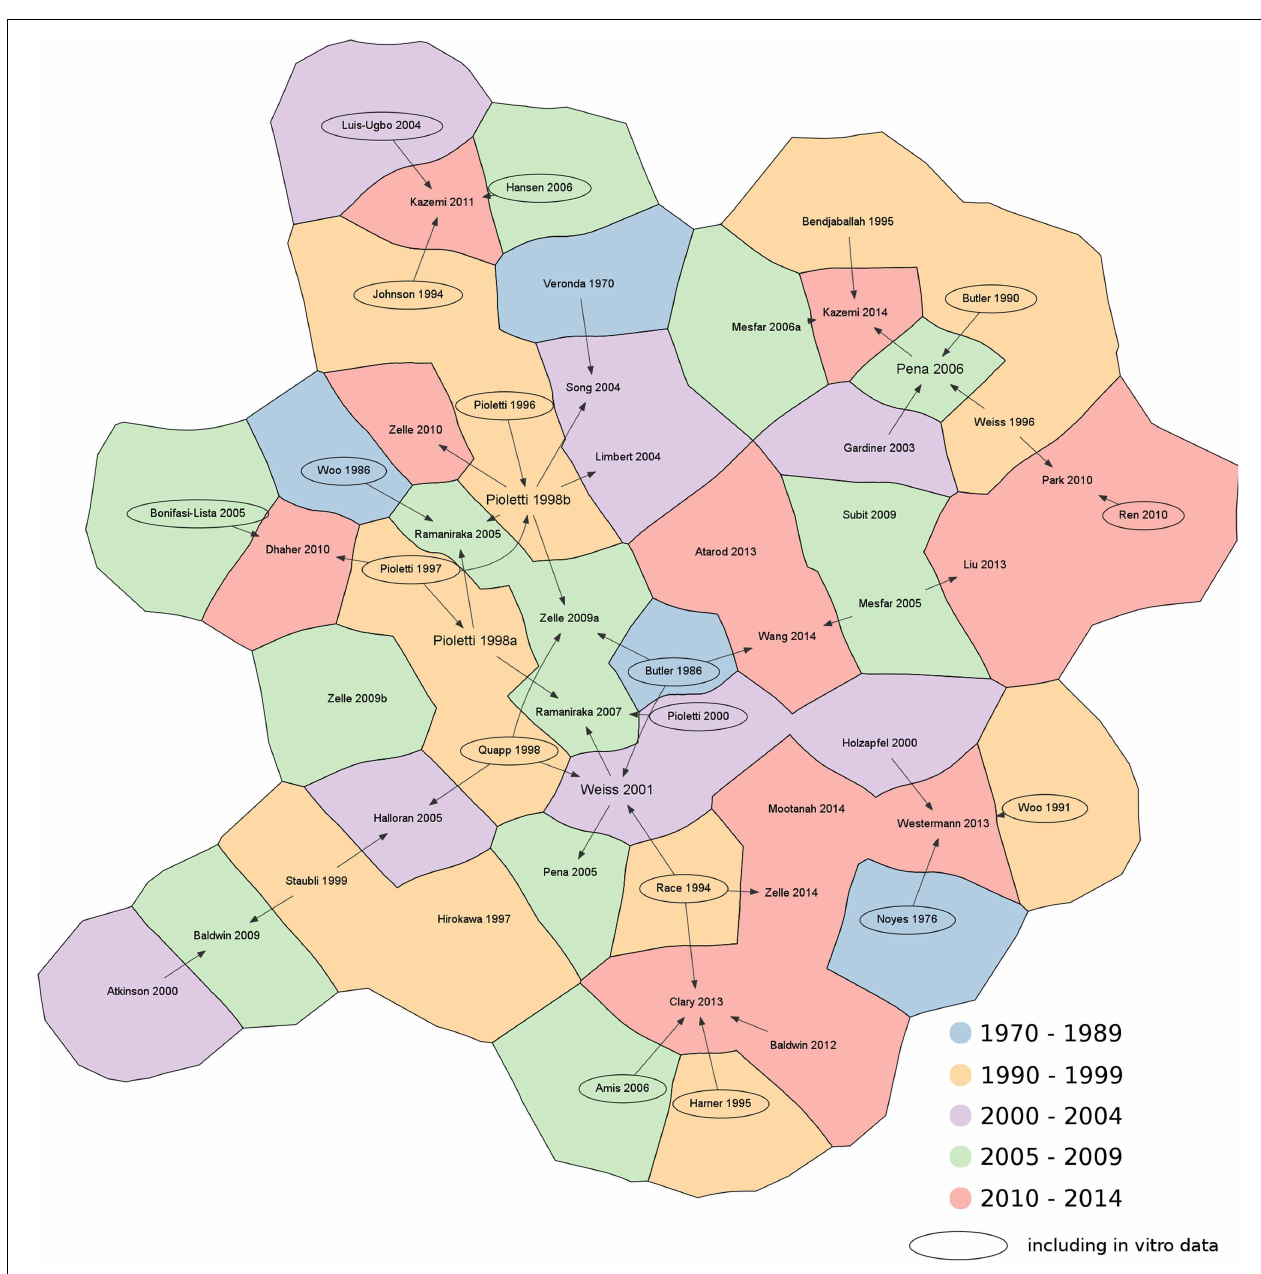
FIGURE 4 | Citation chart showing the sources of each paper retrieved in the literature using 2D and 3D elements to represent the knee ligaments . Arrows indicate the papers used as reference for the material properties of the ligaments. Studies including in vitro data are highlighted with an oval border. For the sake of brevity, only the name of the first author is